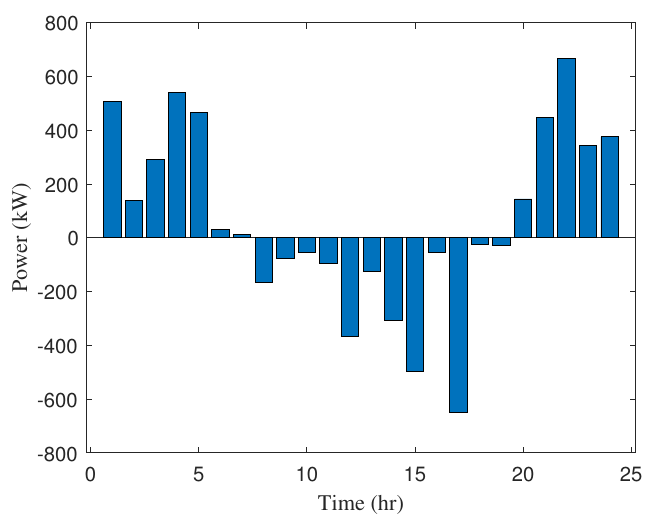
Figure 7. Demand − response schedule with forecast PV and wind